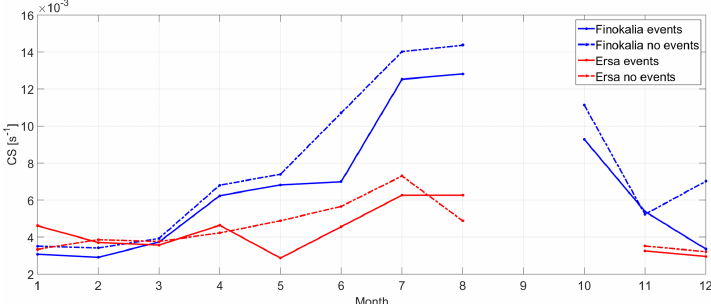
Figure 6. Median values of condensation sink (CS) reported separately for event and non-event days in Finokalia and Ersa.